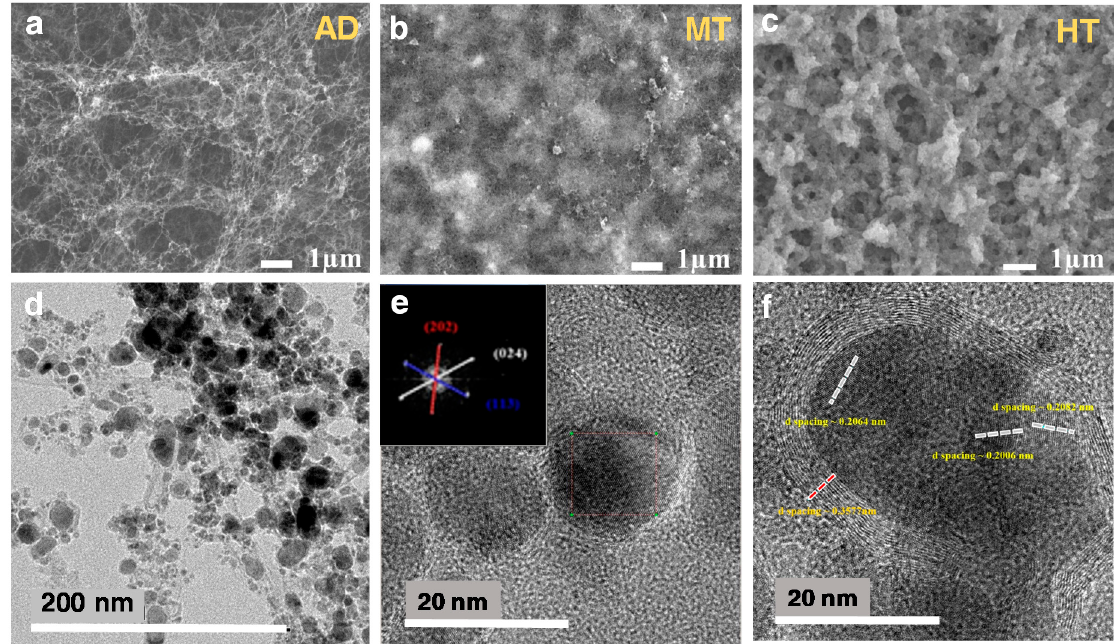
Figure 2. Top-view SEM images of the ( a ) AD, ( b ) MT, and ( c ) HT samples. ( d ) The TEM image of HT showing hematite nanoparticles entangled with the single-wall carbon nanotube (SWCNT) network. High-resolution (HR)TEM images confirms the existence of ( e ) amorphous and ( f ) graphitic carbon layers on the surface of hematite particles.